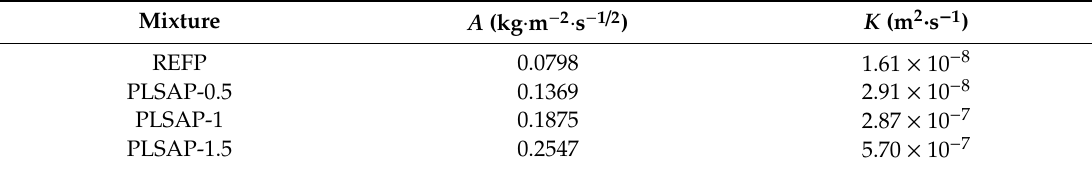
Table 3. Moisture transport properties of studied